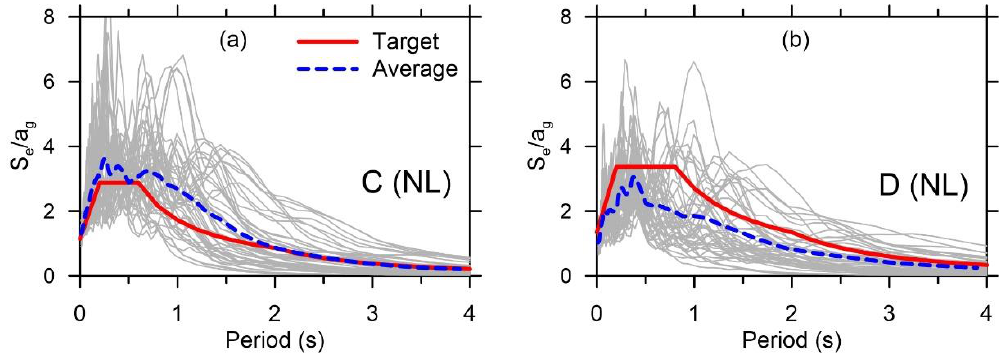
Figure 7. Spectral shapes from the nonlinear (NL) analyses with the design spectrum: ( a ) site classes C; ( b ) site classes D.